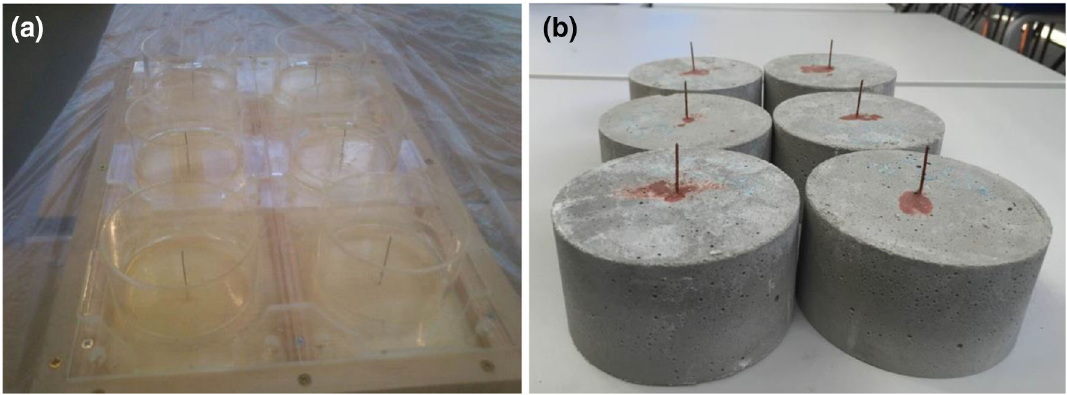
Fig. 3 Single fiber pullout moulds and specimens. a Moulds, b specimens.